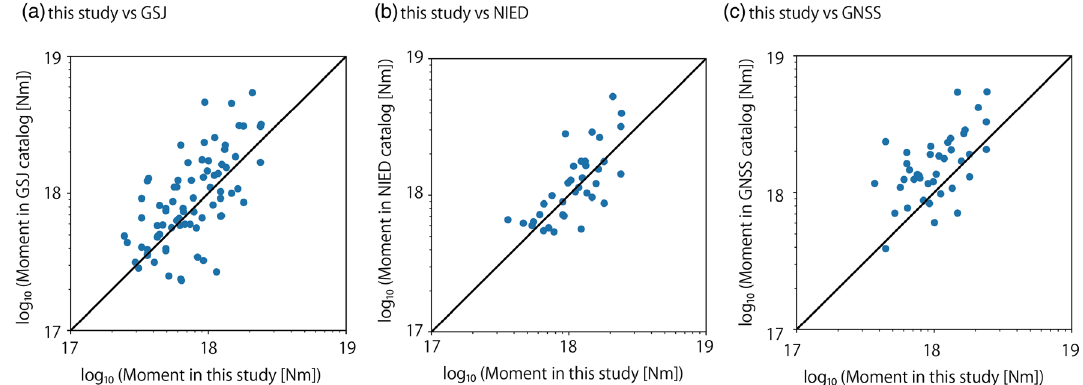
Fig. 8 Comparisons of seismic moments in different catalogs. a Comparisons between GSJ catalog and a catalog of this study. b Comparisons between NIED catalog and a catalog of this study. c Comparisons between GNSS catalog and this study’s